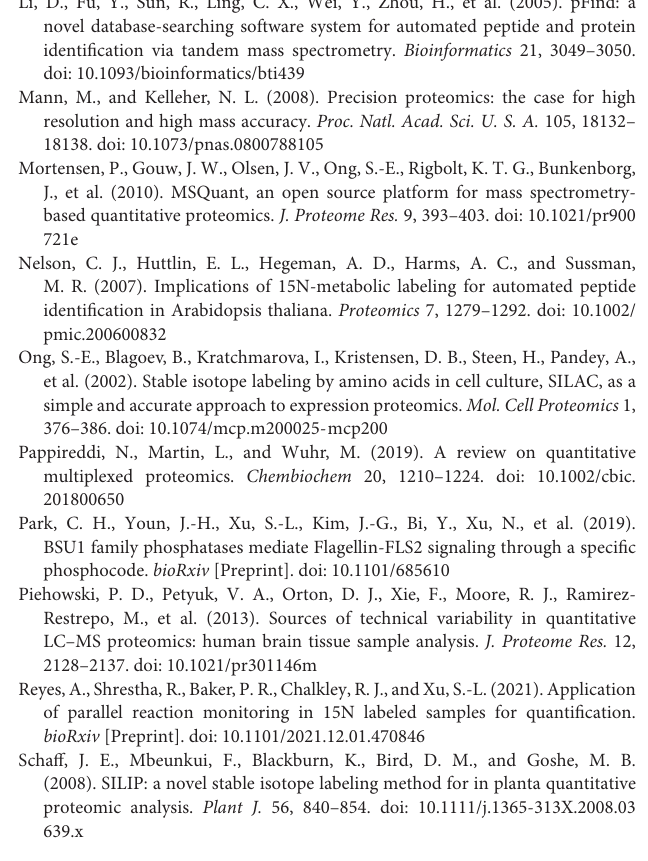
Supplementary Figure 1 | Using MS-Isotope module in Protein Prospector to generate theoretical 15 N peak pattern. (A) Users need to input either composition [1] or sequence of the peptide (not shown) and input the 15 N incorporation rate [2]. (B) Protein Prospector will generate theoretical peaks and percentage number based on input from (A) . Supplementary Figure 2 | Incorporation of the 15 N into the Arabidopsis Col samples was 97%. (A–H) Eight 15 N peptides from different proteins were examined to determine the labeling efficiency, with the left showing theoretical peak pattern at 97% labeling efficiency for all the peptides, and the right (M, M+1, M+2, colored in red) showing the experimental peak pattern and calculated labeling efficiency. Smaller m/z peptides are more preferred to determine the labeling efficiency, because the monoisotopic peak (M) is the largest peak and can be set as 100% maximum during calculation. Supplementary Data 1 | R script used to generate the median and Q1/Q3 for